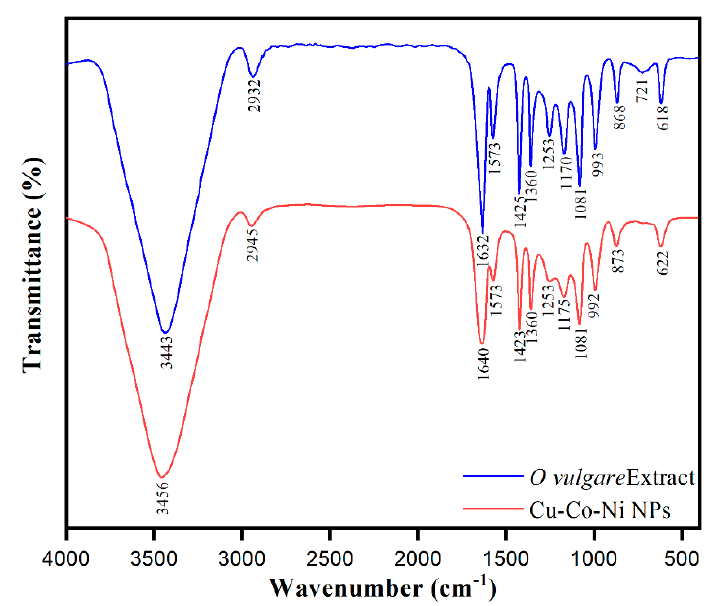
Figure 4. Fourier transform infrared (FTIR) spectra of Origanum vulgare extract and biosynthesized Cu-Co-Ni trimetallic nanoparticles.